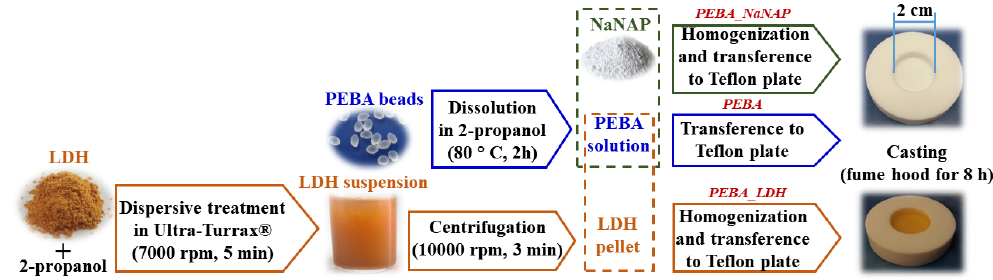
Figure 2. Schematic representation of PEBA membrane and composite preparation processes.